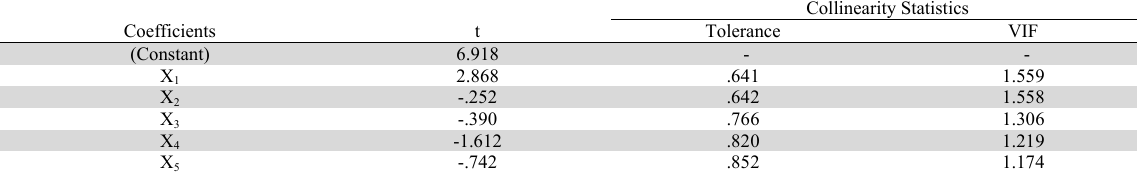
Multicollinearity test results